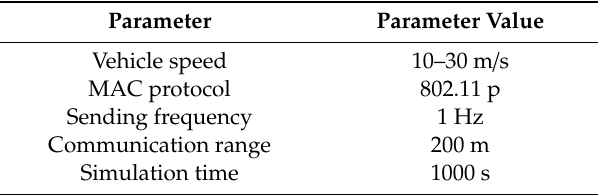
Table 2. Experimental